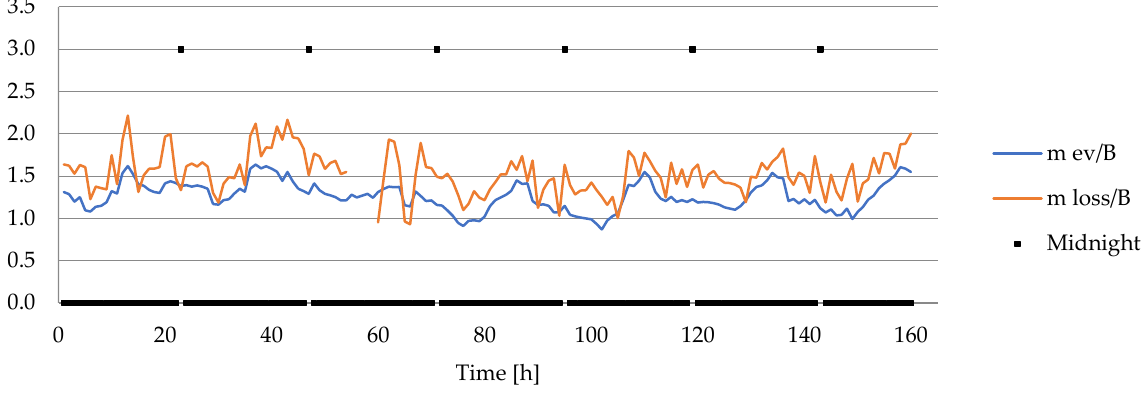
. m a /100 [m 3 /h], and Merkel number ( Me · 1000).